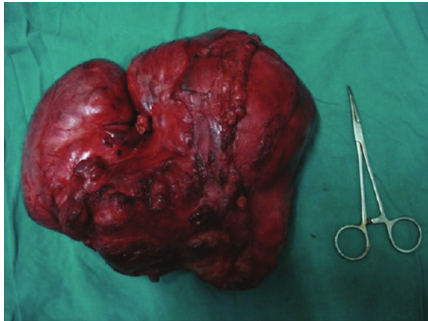
Figure 4: Resected